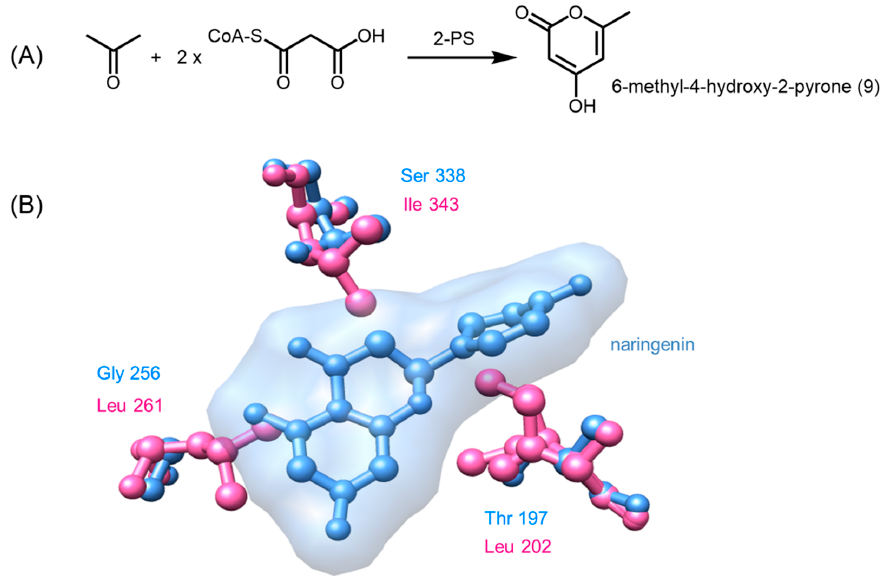
Figure 4. Comparing residues lining the active site of G. hybrida 2-PS and M. sativa CHS. ( A ) 2-PS catalyzes the condensation of acetyl-CoA with two units of malonyl-CoA to form 6-methyl-4-hydroxy-2-pyrone; ( B ) the structures of 2-PS (pink, PDB ID: 1QLV) and CHS (blue, PDB ID: 1CGK) were aligned to compare the active site cavity between the two structures. The presence of the three bulkier residues in 2-PS (L202, L261, and I343) show that a tetraketide such as naringenin will not fit inside the active site. Thus, only